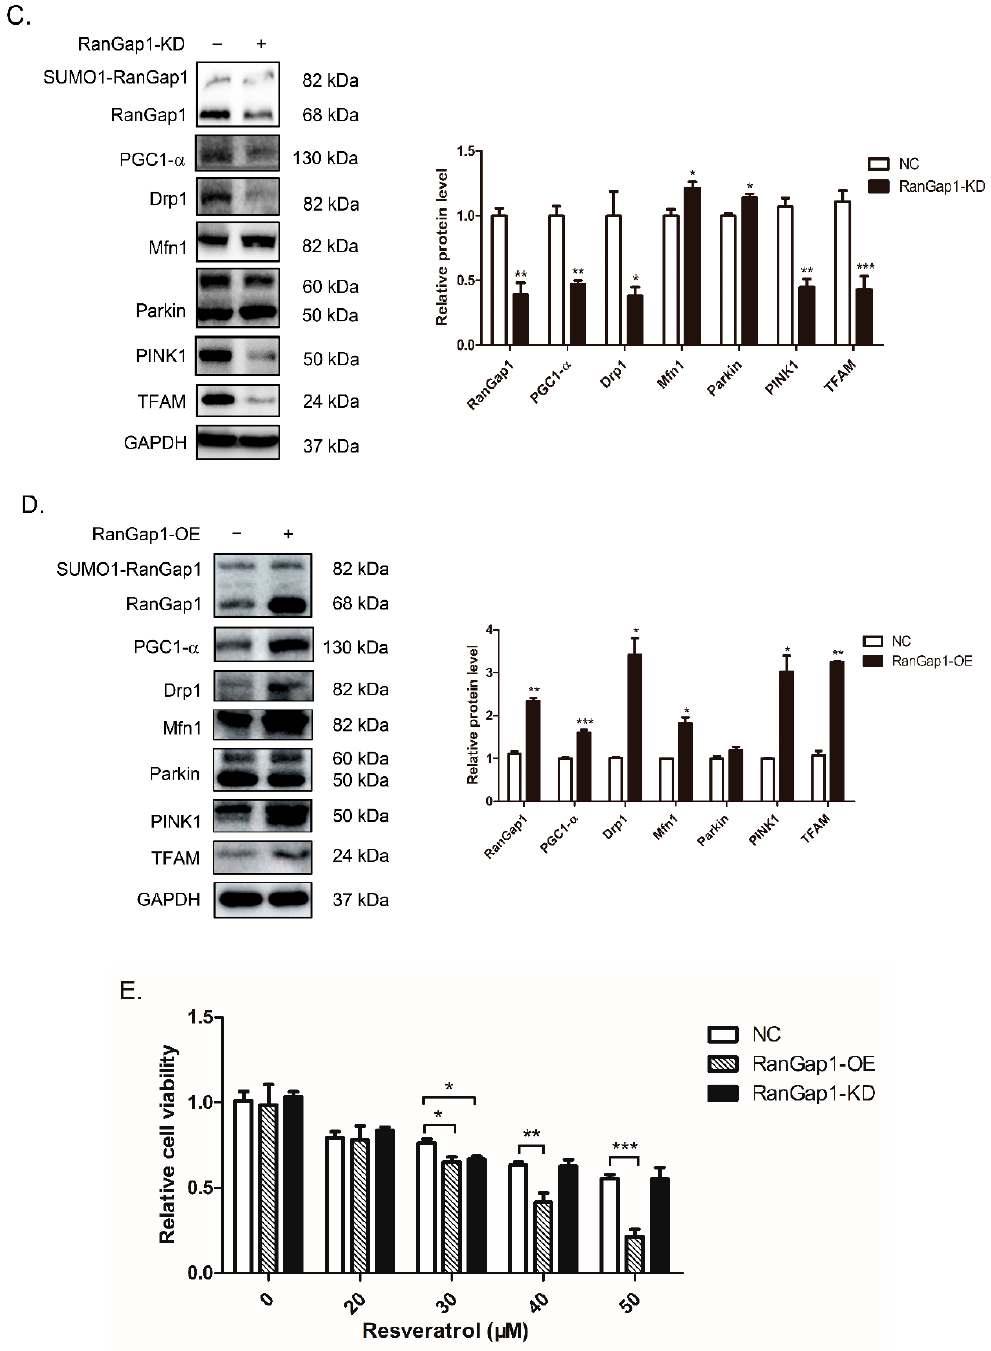
Figure 5. RanGap1 affects antioxidant capacity and mitochondrial functions. ( A ) The ROS level was decreased in SIRT1-KD cells and increased in SIRT1-OE cells. ( B ) The ROS level was increased in RanGap1-OE cells and did not have obvious changes in RanGap1-KD cells. ( C ) PGC1- α , Drp1, PINK1 and TFAM were decreased, and Mfn1 and Parkin were increased in RanGap1-KD cells. ( D ) PGC1- α , Drp1, Mfn1, PINK1 and TFAM were increased in RanGap1-OE cells. ( E ) The cell viability was significantly decreased in RanGap1-OE cells under treating with 30 to 50 μ M resveratrol compared to control cells. DMSO was used as negative control. The GAPDH was used as a loading control. The pooled data were shown here as the mean ± SEM, and the significant differences from control cells were shown in p < 0.05 (*), p < 0.01 (**), and p < 0.001 (***). The independent experiments were repeated at least three